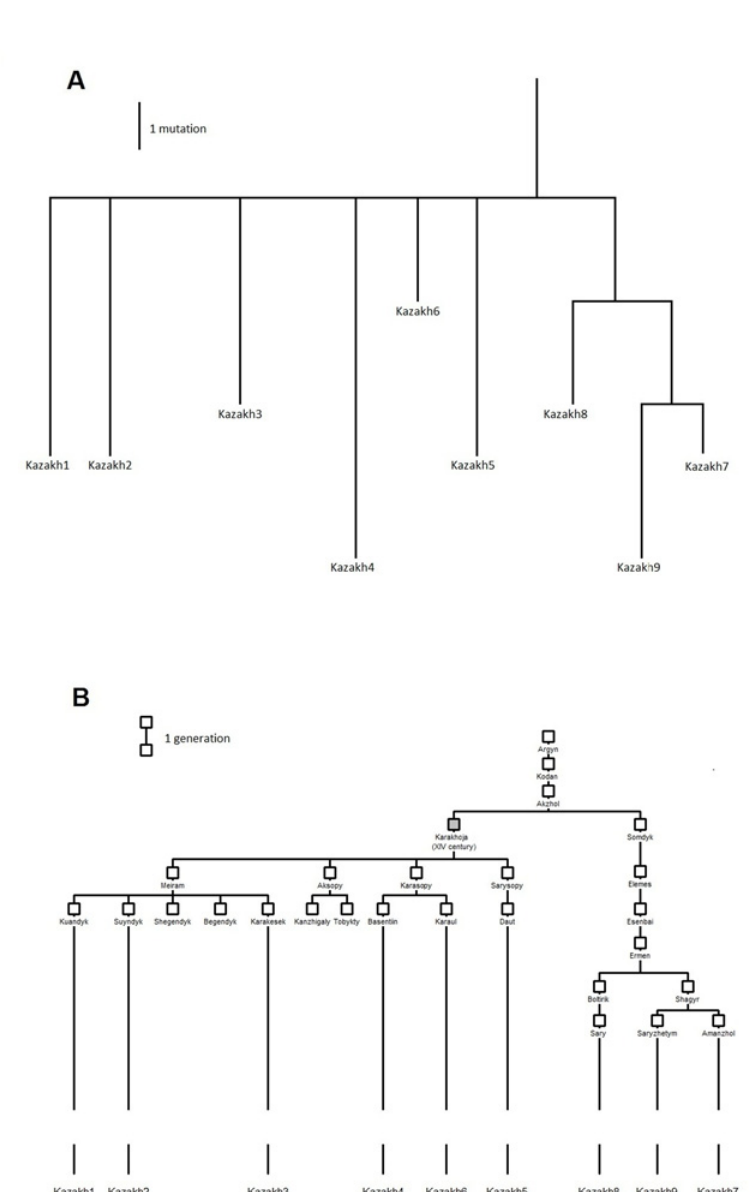
Fig 6. Genetic and genealogical reconstructions of the relationship between members of the Argyn tribe of the Kazakh: A) Genetic tree reconstructed from Y-chromosome sequences of the Kazakh samples. B) Genealogical tree of the Argyn tribe of the Kazakh. Each sequenced Kazakh sample is attributed to the clan it originates from. The genealogical ancestor with the known historical date is marked in